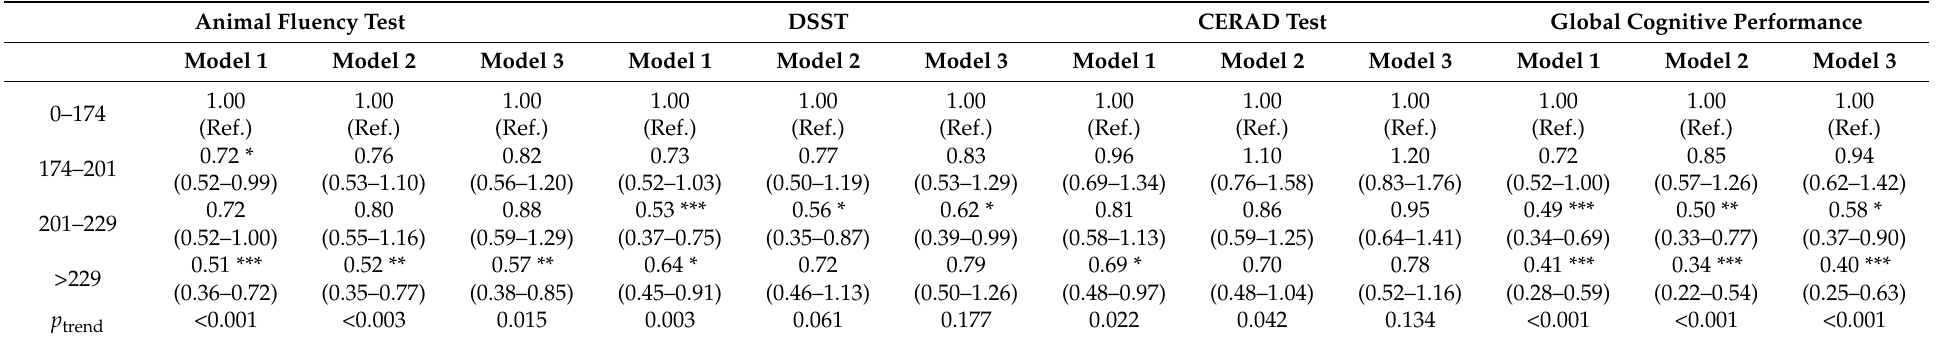
Table 4. Odds ratios (95% confidence intervals) for four dimensions of cognitive performance across quartiles of total cholesterol among female